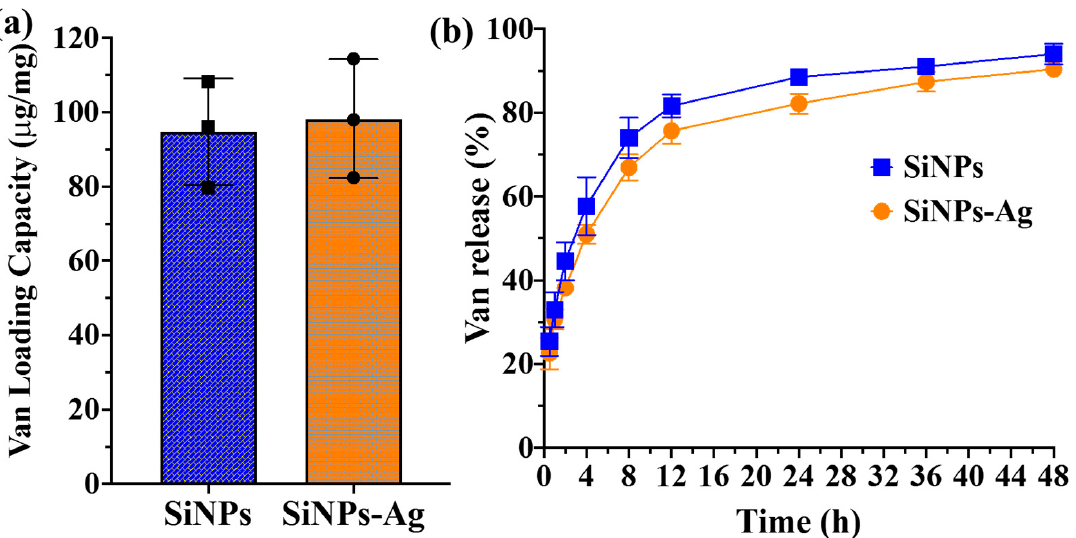
Figure 2. Vancomycin loading capacity ( a ) and release profile in PBS ( b ) for SiNPs and SiNPs-Ag. Error bars represent standard derivation ( n = 3).